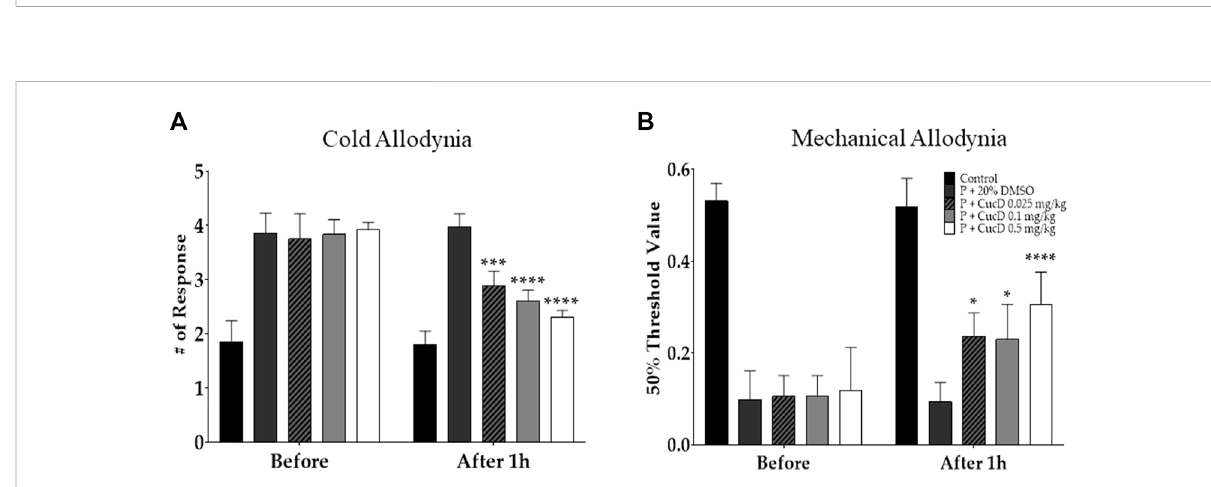
FIGURE 6 Dose-dependenteffectofcucurbitacinD(CucD)oncoldandmechanicalallodyniainducedbymultiplepaclitaxelinjectionsinmice.Behavioral tests were performed twice: before (before) and 1 h after (after 1 h) the i. p. injection of 20% DMSO or of .025, .1, or .5 mg/kg of CucD in paclitaxel- injectedmice. Experimentswereconducted 15 daysafter the fi rstpaclitaxelinjection. Cold (A) andmechanical (B) allodynia assessments weremade via theacetone droptestandvon Frey fi lament assay,respectively.P, paclitaxel; CucD, cucurbitacin D;DMSO, dimethyl sulfoxide. N =7in each group. * p < .05, *** p < .001, and **** p < .0001 vs. before with two-way ANOVA, followed by Tukey ’ s post-test for multiple